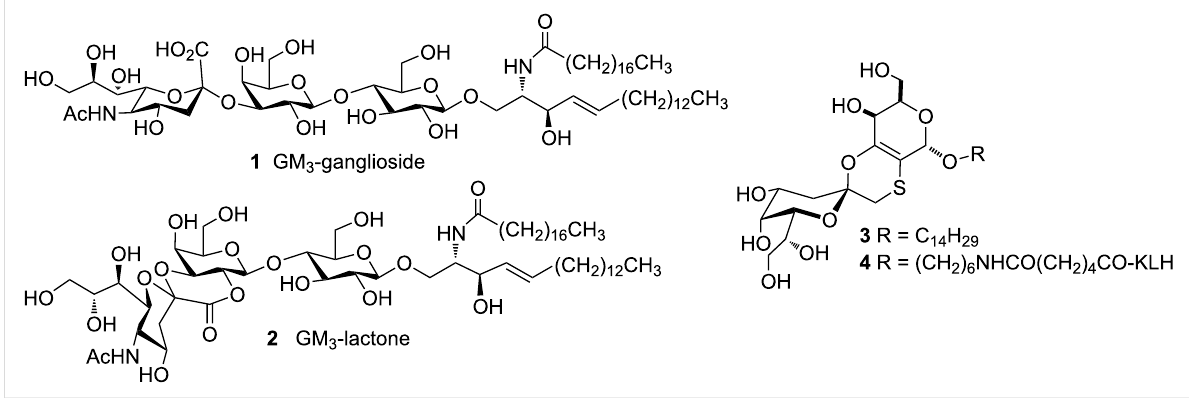
Figure 1: Structure of GM 3 -ganglioside 1 , GM 3 -lactone 2 , GM 3 -lactone mimetic 3 , and GM 3 -lactone mimetic conjugated to KLH protein ( 4